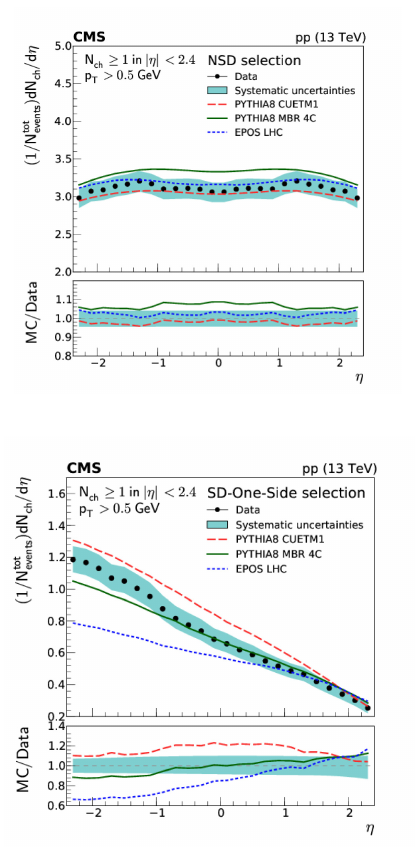
Fig. 2. Normalized differential charged particle multiplicity distributions as a function of pseudorapidity for the different sample selections. The error band represents the total systematic uncertainty